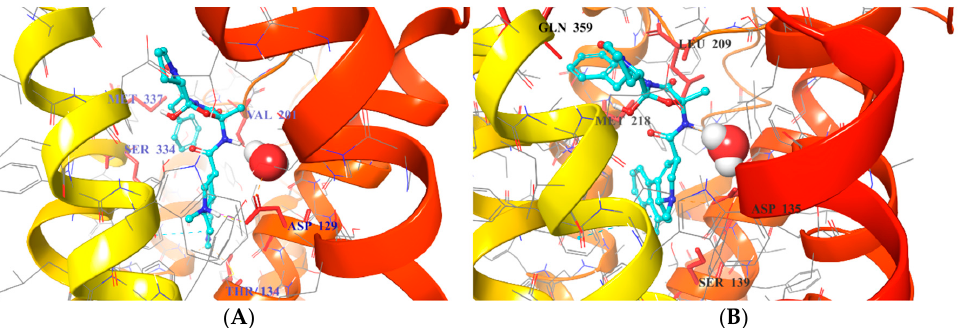
Figure 5. Residues (red) used in pose filtering for 5-HT 1B R (PDB ID: 4IAQ) panel ( A ) and 5-HT 2B R X-ray structures (PDB ID: 4IB4) panel ( B ); Water molecules forming interactions with the Asp 3.32 shown as a sphere representation.